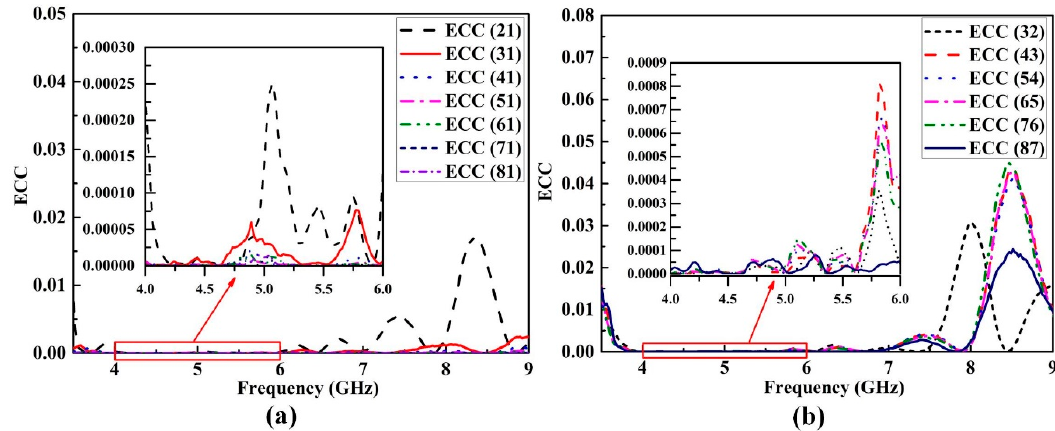
Figure 11. Measured efficiency of the eight-element MIMO antenna.